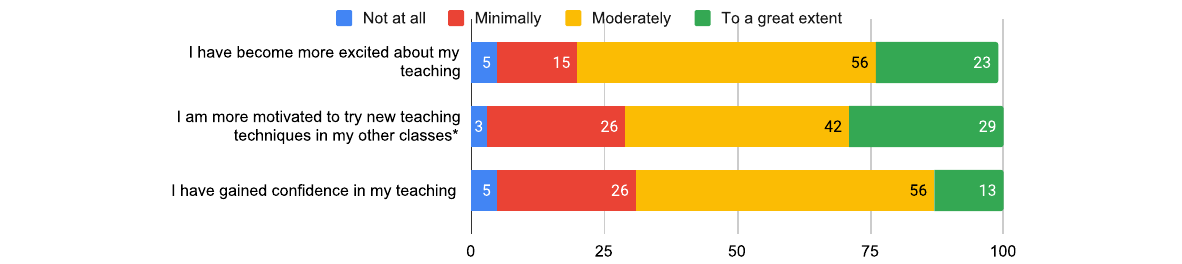
Fig. 6 Attitude toward teaching. Percentage of respondents reporting benefits to participating in the FOLC in spring 2019 (end of year two of the FOLC). Participants rated the extent to which each benefit had occurred as a result of their participation in the FOLC. Items were not presented to participants in this order or identified with the category attitude toward teaching . ( N = 39, except for *. N = 38 for * items)